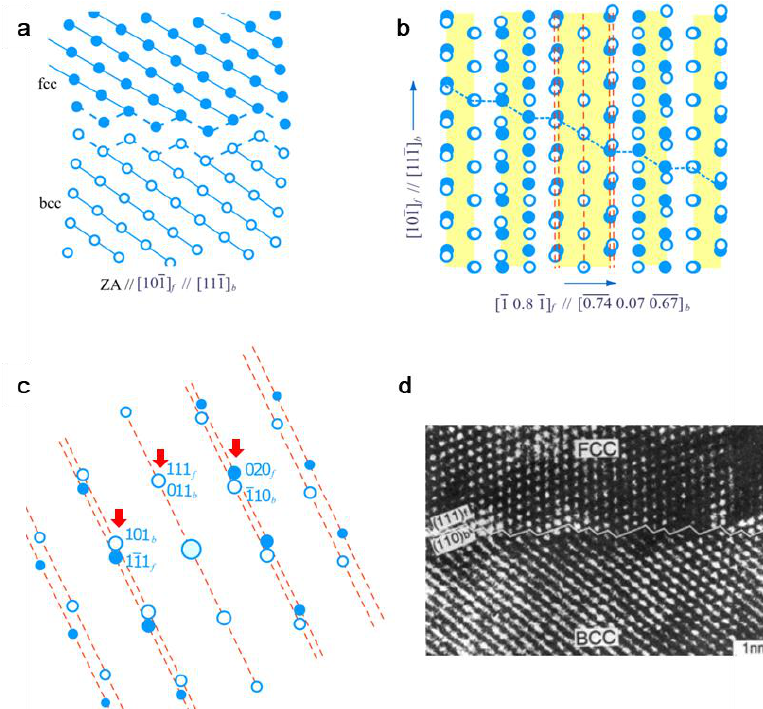
Figure 5. The atomic row matching in the irrational (1 2.4 1) f interface at K–S OR for an fcc/bcc system with λ = √6/2 . ( a ) Atomic matching viewed from the [10−1] f //[11−1] b direction with interface edge-on. ( b ) Atomic row matching at stepped interface layer. ( c ) Simulated diffraction pattern of ( a ). ( d ) Observation of the stepped structure in an Ni-Cr alloy.